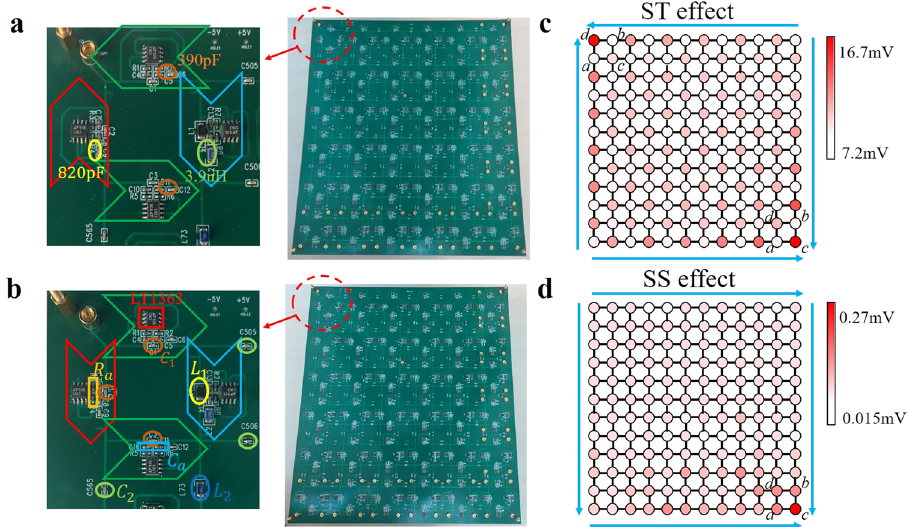
Fig. 3 The photograph of fabricated sample and experimental results for the hybrid second-order skin-topological (ST) and skin-skin (SS) effect. a , b The photograph of the fabricated electric circuit for the hybrid second-order ST effect ( a ) and SS effect ( b ). The values of the capacitors and inductors are the same as theoretical design. Arrows with different colors are the same as INICs labeled in Fig. 1d. The inset presents the enlarged view of the unit cell. c , d The measured voltage distribution at the resonance frequency for the hybrid second-order ST effect and SS effect in ( c ) and ( d ), respectively. Each unit cell contains four sublattices ( a , b , c , d ). Big arrows in ( c ) show the directions of skin and topological pumping. Big arrows in ( d ) show the directions of skin